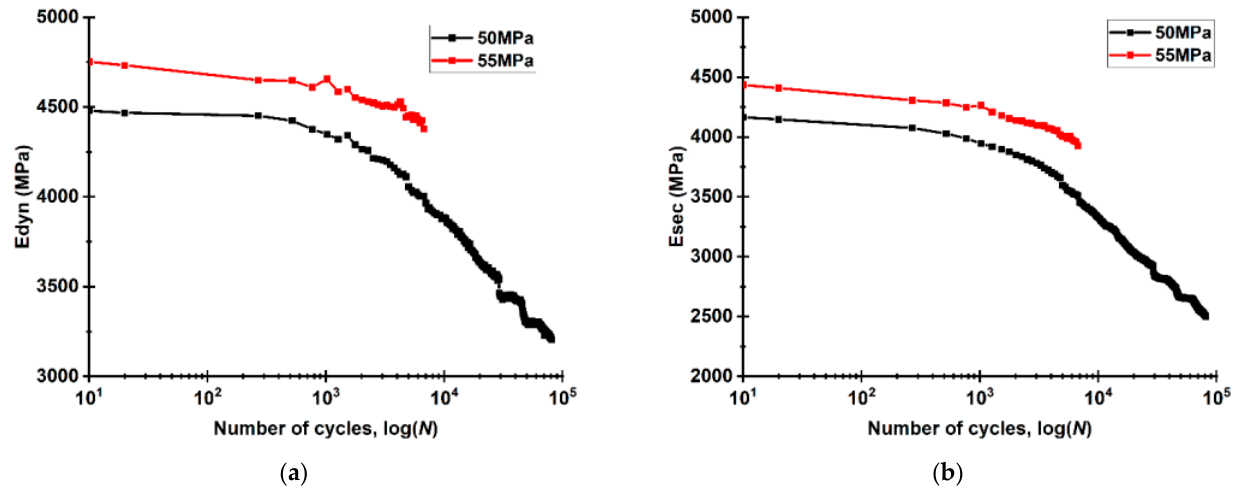
Figure 13. The changes in the dynamic characteristics of the USW lap joints in the fatigue tests: dynamic ( a ) and secant ( b ) moduli.